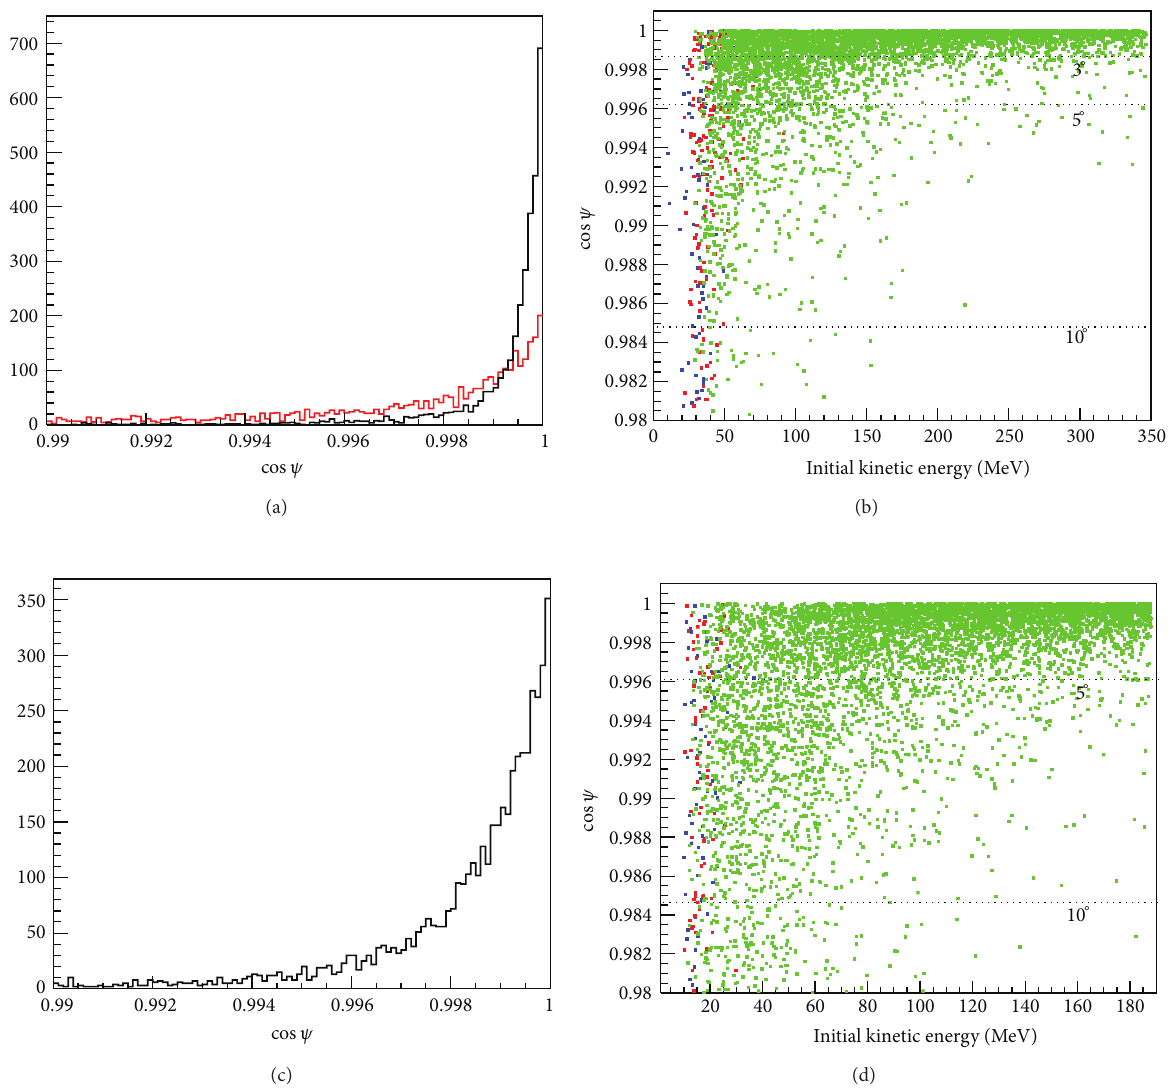
Figure11:Distributionoftheangle 𝜓 betweenthereconstructedandthesimulatedparticleinitialdirections:(a)protons,initial 𝐸 𝑘 = 232 MeV (range 30cm); the new 3D reconstruction-black curve, 2D hit matching-red curve; (b) protons, initial 𝐸 𝑘 : (10–350)MeV (range up to 60 cm); dots color: 1, 2 hits in the track-blue, 3 hits in the track-red, 4 and more hits in the track-green; (c) muons, initial 𝐸 𝑘 = 100 MeV (range 30 cm); (d) muons, initial 𝐸 𝑘 : (10–185)MeV (range up to 60cm); colors are the same as in